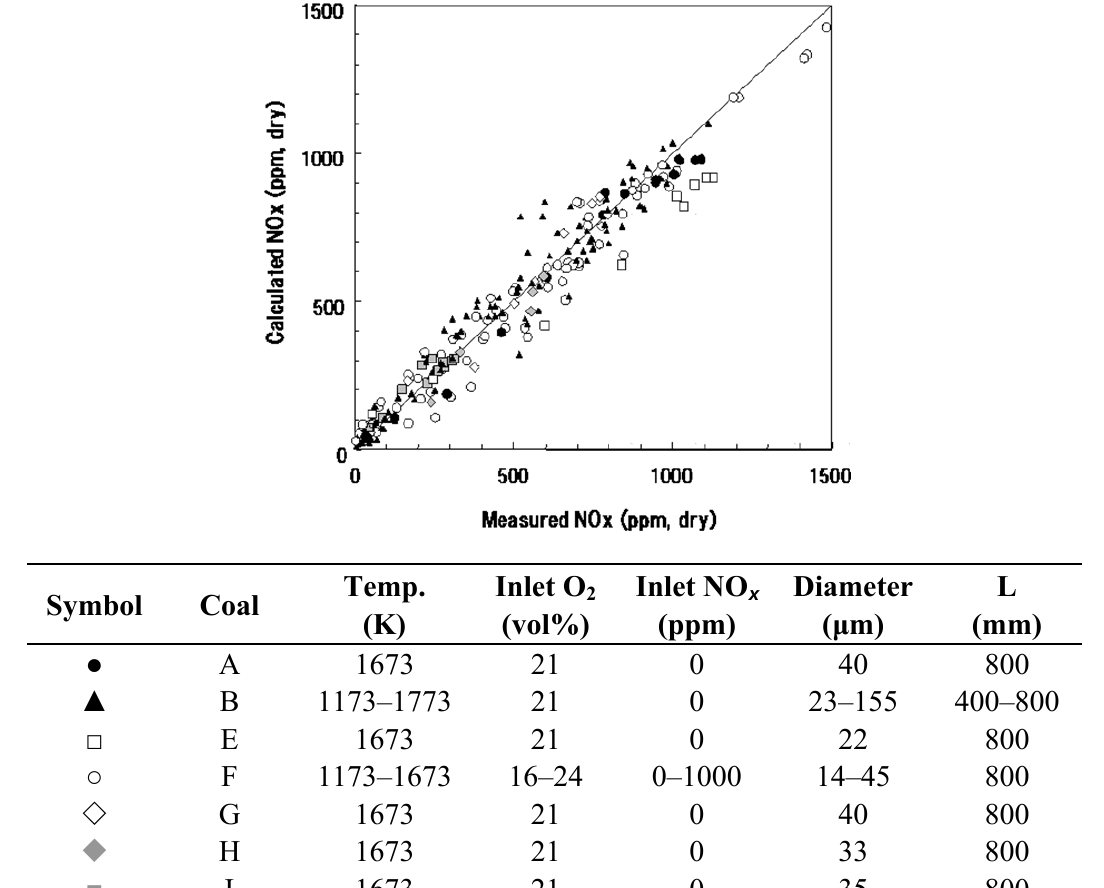
Figure 5. Comparison between measured (symbols) and calculated (line) NO